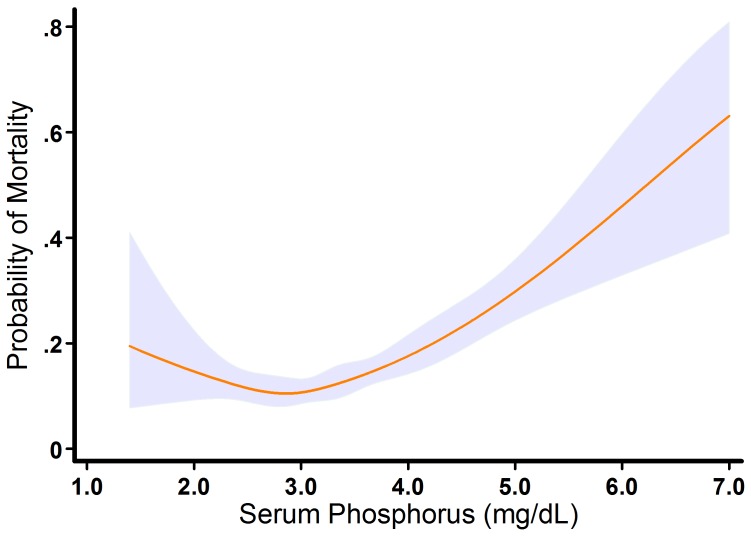
Cubic spline analysis.The plot describes the relationship between serum phosphorus as a continuous variable and the probability of mortality. The blue area indicates the 95% confidence interval.